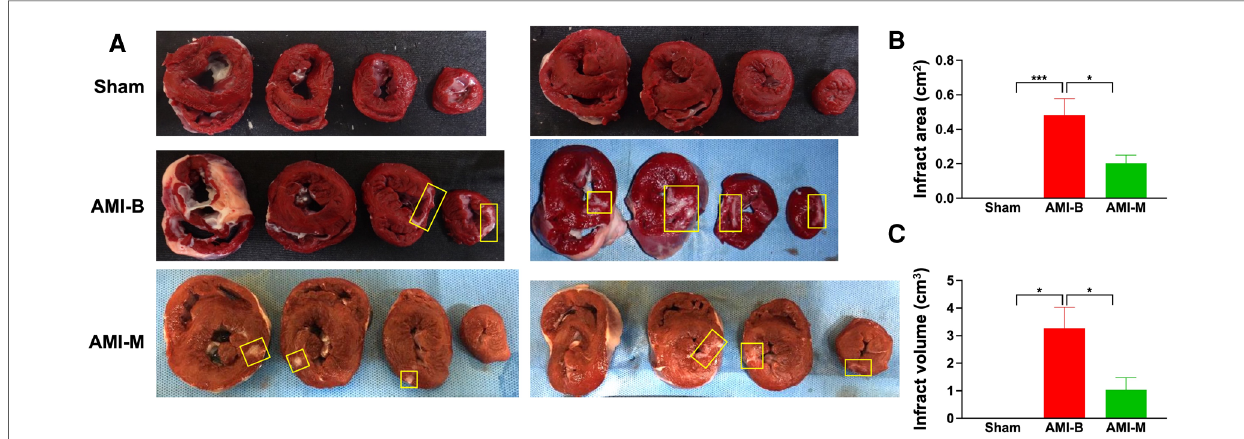
FIGURE 3 MMT assay for assessing the infarct area and infarct volume 5 months after AMI induction. ( A ) The cross-section of MTT assay for identi fi cations of infarct area (i.e., at papillary muscle level). Yellow square boxes indicated the infarct area. ( B ) Analytical result of infarct area, * indicated p <0.01; *** p <0.0001.